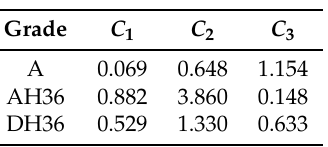
Table 3. Identified fracture model